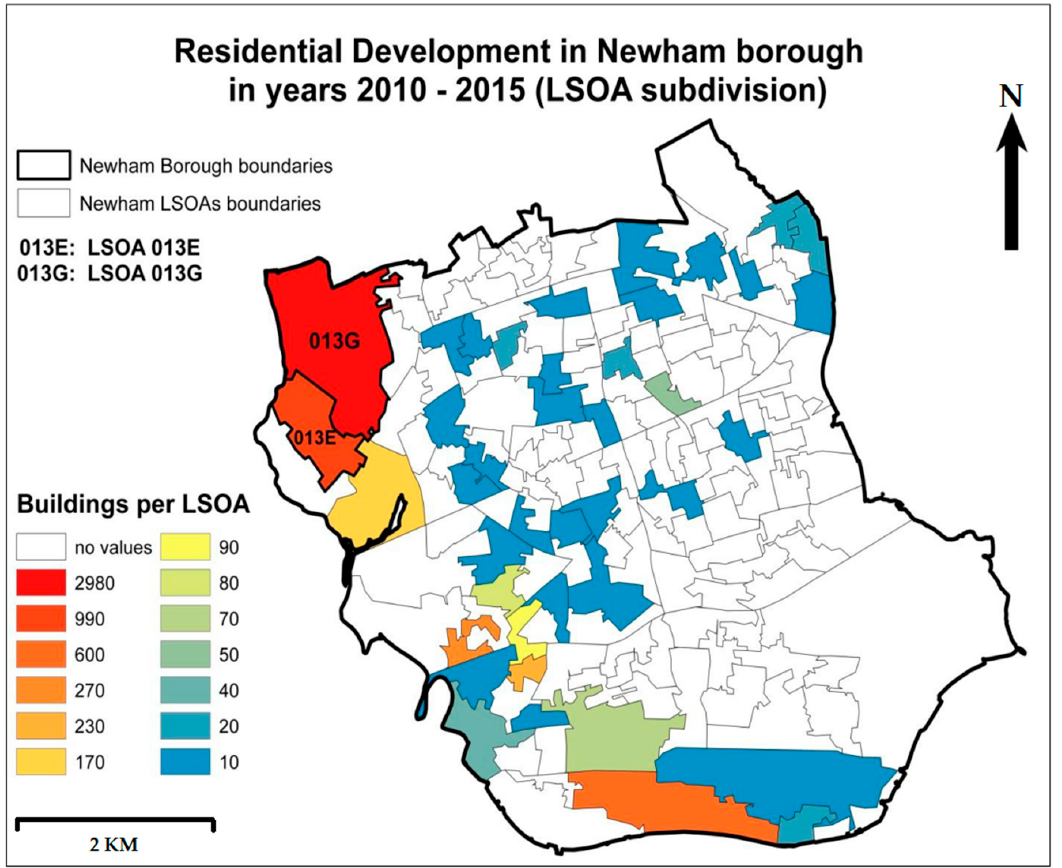
Figure 4. Map showing the number of new buildings 2010–2015 per LSOAs within the boundaries of Newham borough. The chosen LSOAs 013E and 013G are outlined. Contains National Statistics data © Crown copyright and database right (2015) and (2012). Contains Ordnance Survey data © Crown copyright and database right (2015) and (2012).